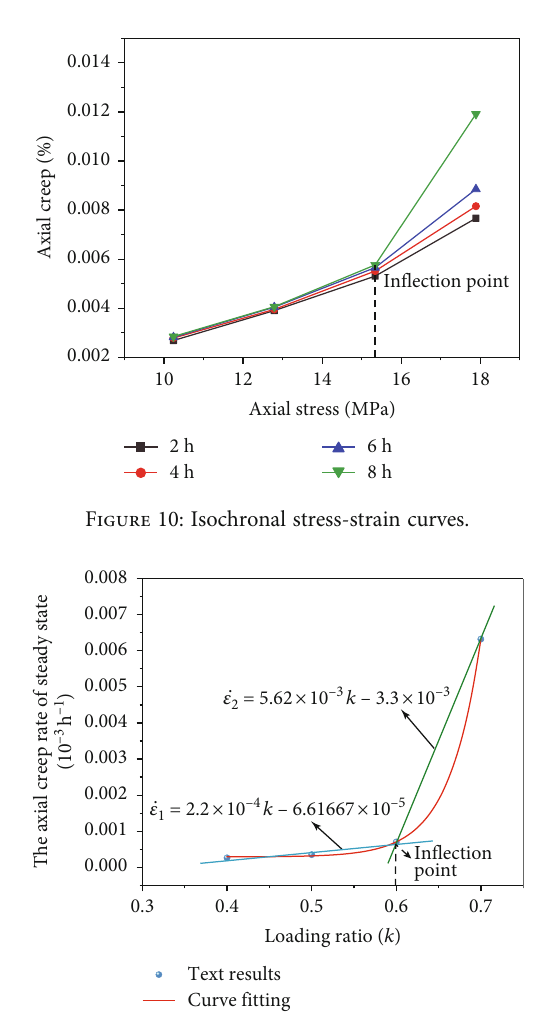
Figure 11: Determination of in fl ection point of steady creep rate.